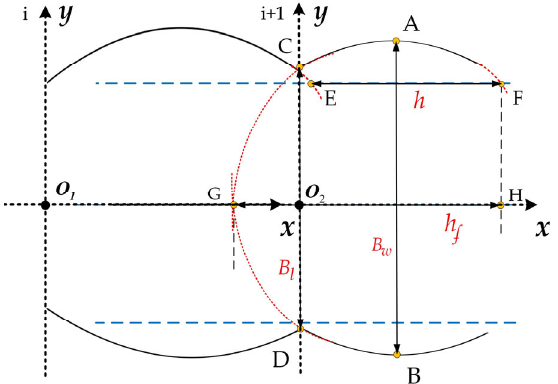
Figure 9. Coordinate positioning diagram of key measurement points.